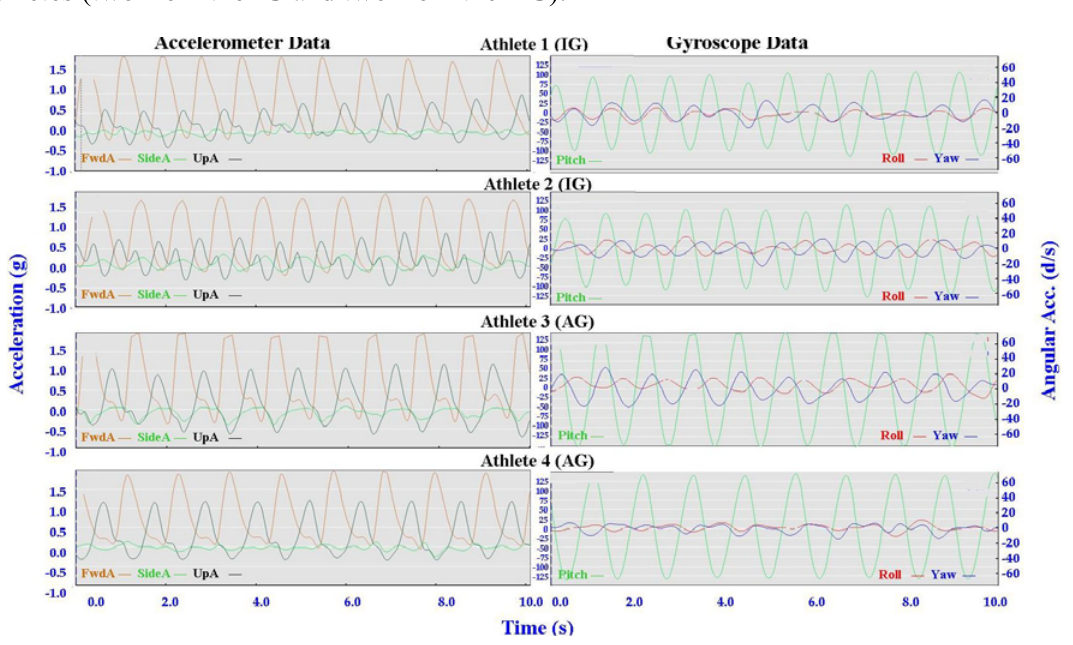
Figure 10. Comparison of Double Pole (DP) gyroscope and accelerometer traces for four athletes (two from the IG and two from the AG).